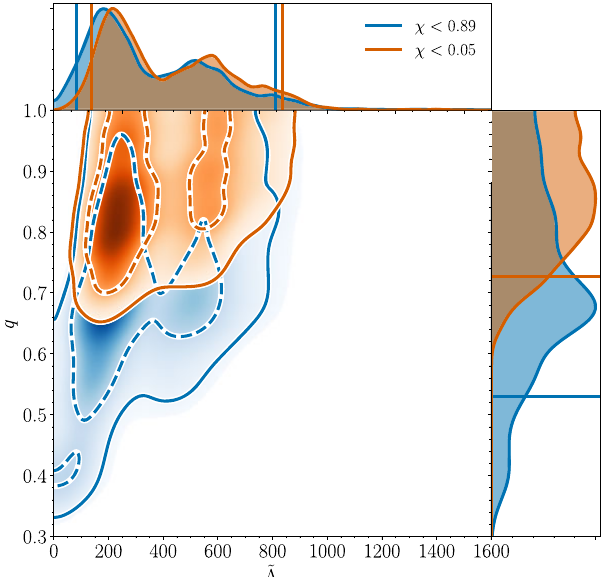
˜ Λ and mass ratio q using ˜ Λ ¼ 0 is due to smoothing ˜ Λ is shown by vertical